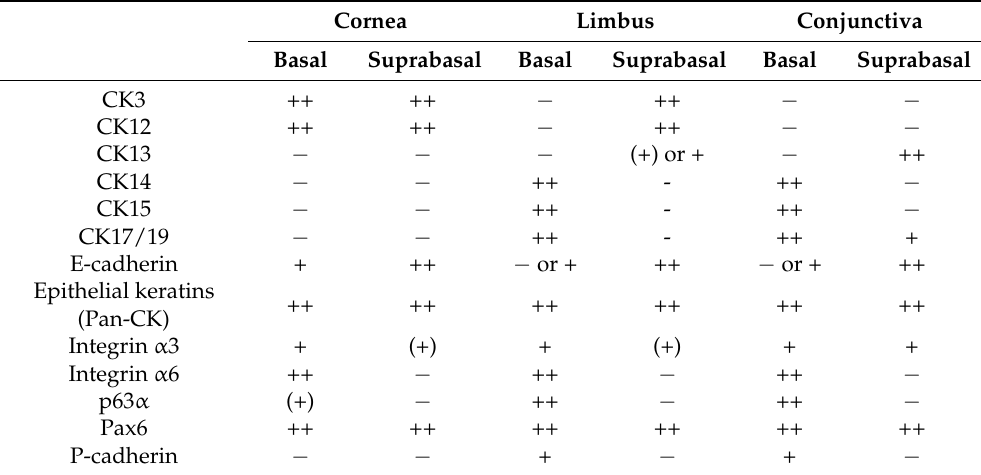
Table 1. A list of epithelial markers and their expression patterns on porcine ocular surface epithe- lial cells. Cornea Limbus Conjunctiva Basal Suprabasal Basal Suprabasal Basal